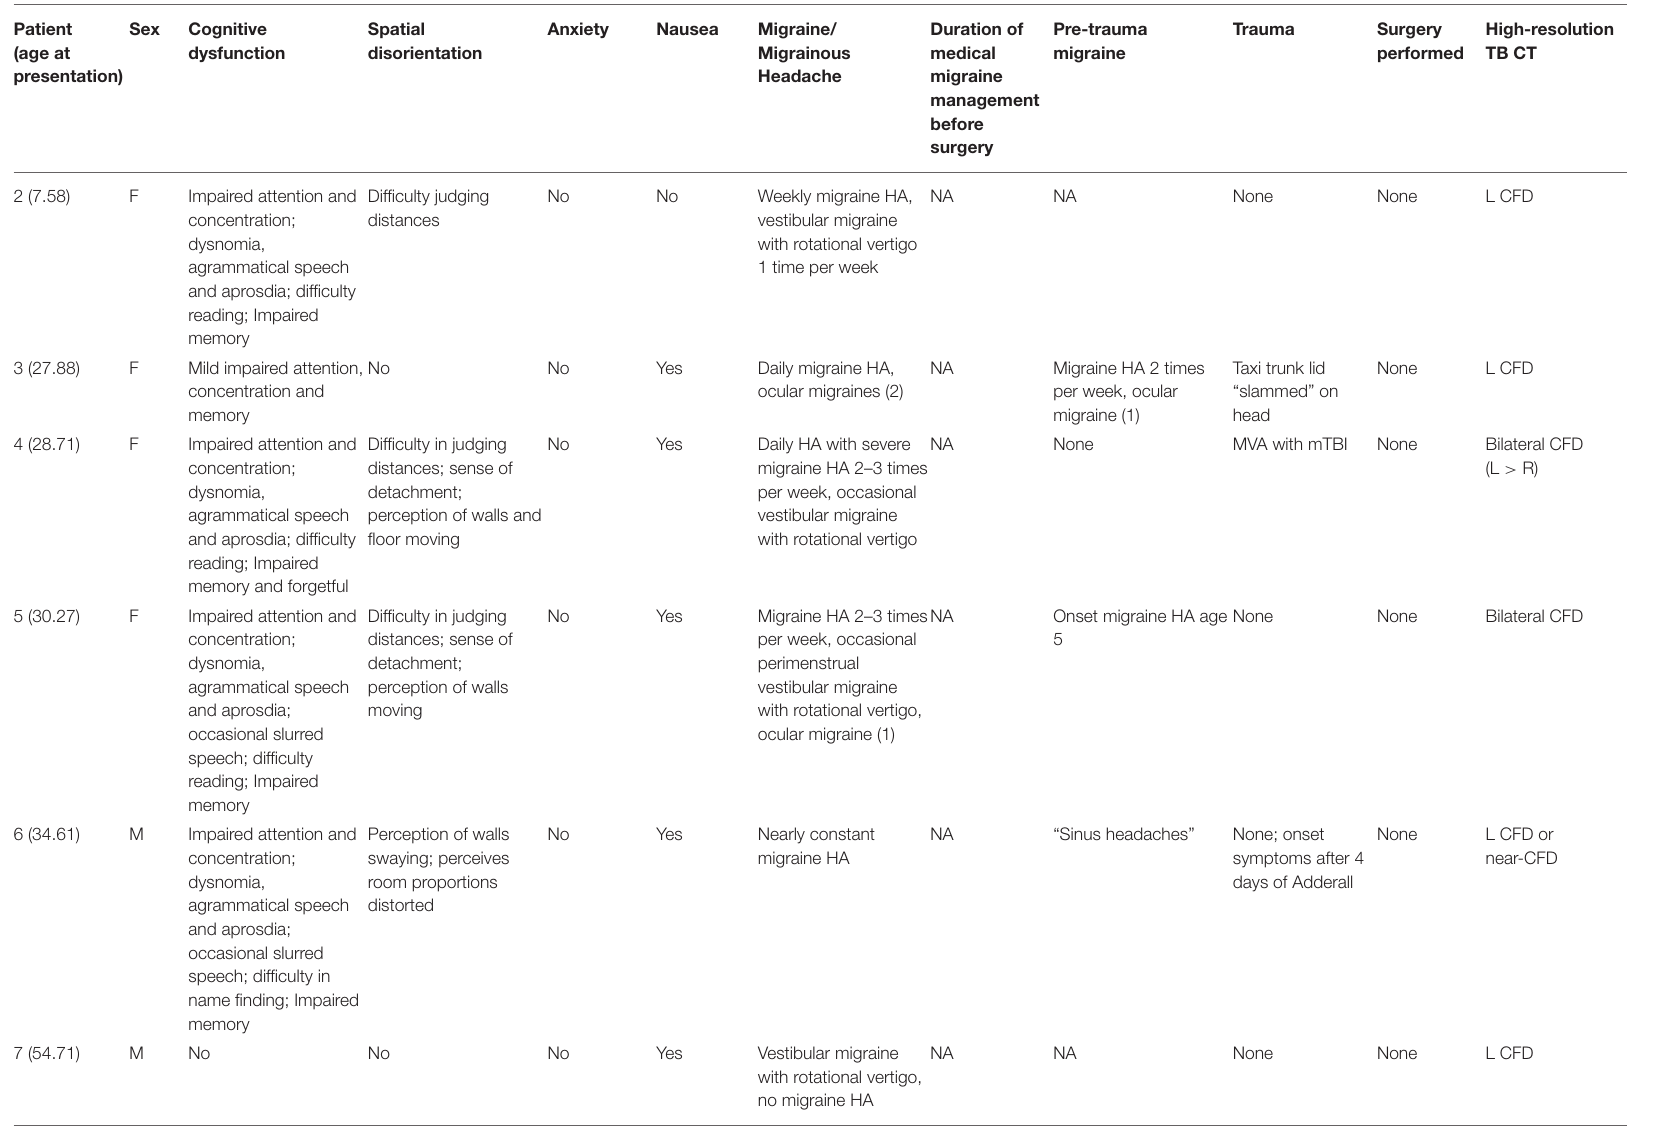
Group 2: Cochlea-facial nerve dehiscence and third window syndrome patients who did not undergo round window reinforcement surgery Patient (age